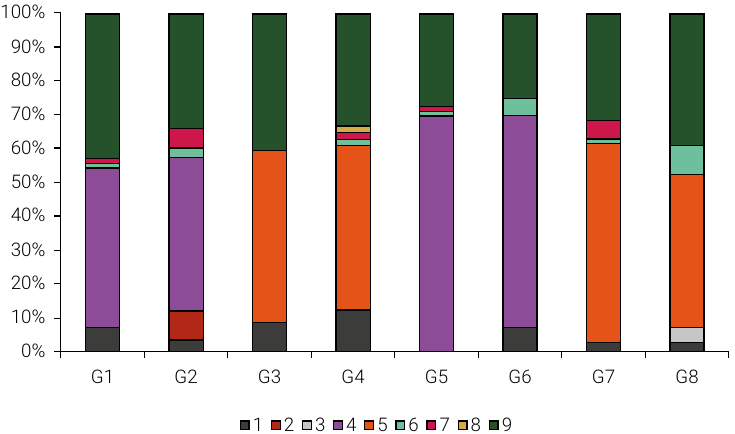
* 1 - adhesive fracture between glass fiber post and luting agent; 2 - adhesive fracture between first and second layers of luting agent; 3 - adhesive fracture between luting agent and composite; 4 - adhesive fracture between luting agent and dentin; 5 - adhesive fracture between composite and dentin; 6 - cohesive fracture of glass fiber post; 7 - cohesive fracture of luting agent; 8 - cohesive fracture of composite; 9 - mixed fracture. Figure 2. Failure pattern (%) of glass fiber posts cemented by different cementation